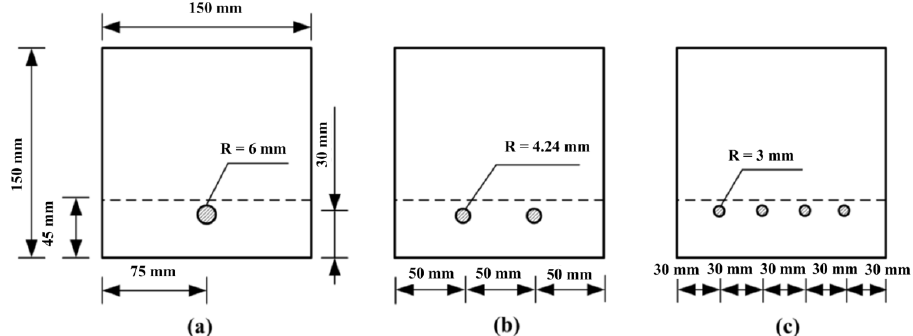
Figure 9. The arrangement of steel bars in the numerical models with: ( a ) one steel bar; ( b ) two steel bars and ( c ) four steel bars, respectively.